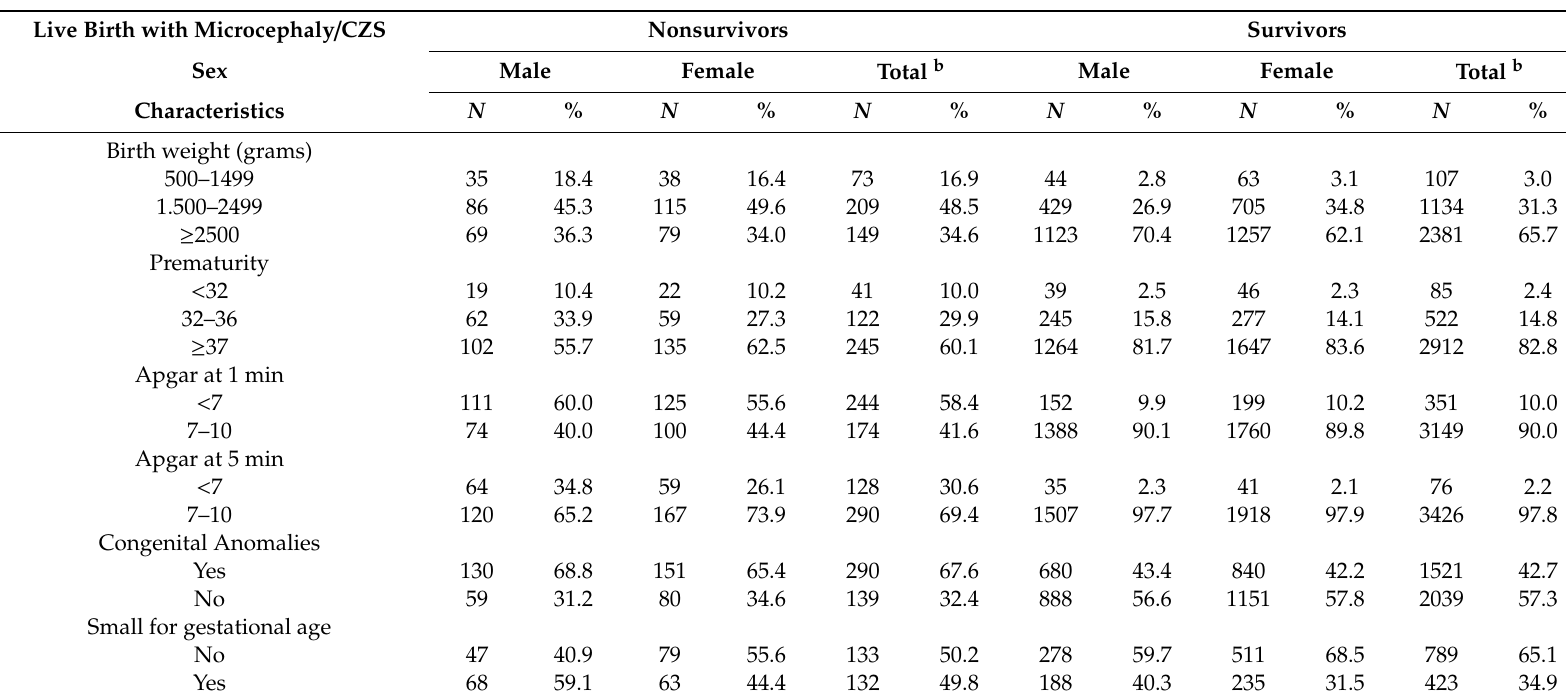
Table 2. Number and percentage of live birth with microcephaly / congenital Zika syndrome (confirmed and possible a ) who died and who did not die according to the child’s clinical characteristics and sex. Brazil, 2015–2017. Live Birth with Microcephaly /